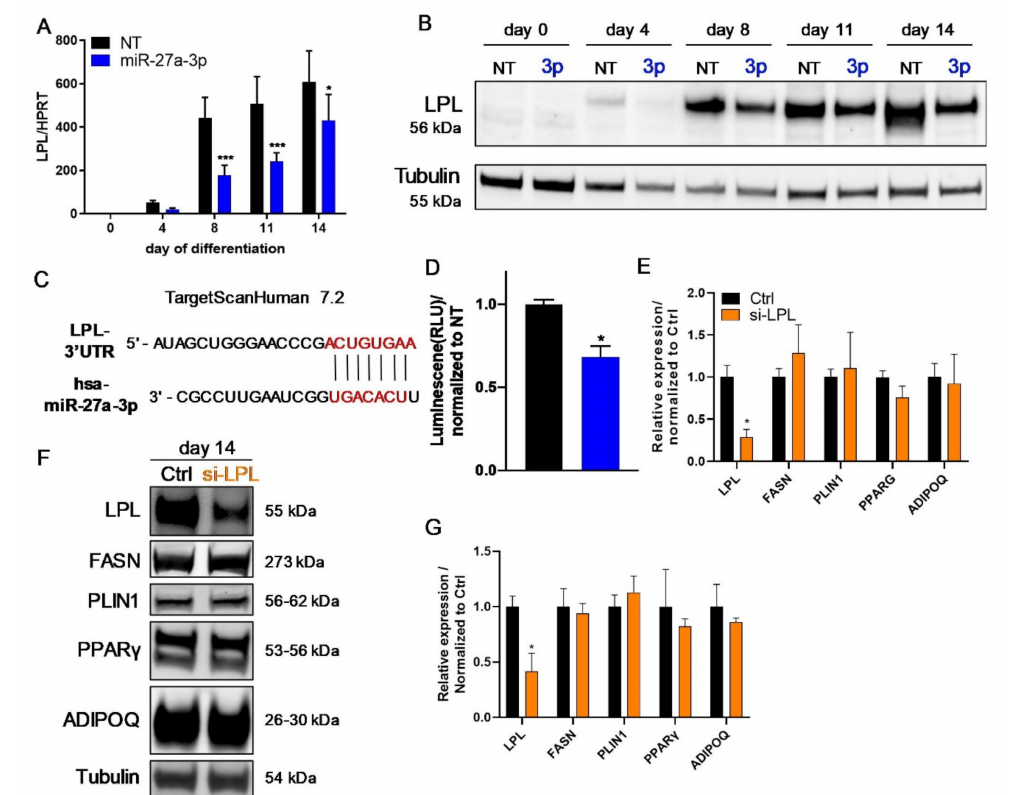
Figure 6. The miR-27a-3p target LPL does not alter adipogenesis. To assess if miR-27a-3p regulated its predicted target, lipoprotein lipase (LPL), SGBS preadipocytes were transfected 48 h prior to adipogenic induction with miRNA mimics or non-target control (NT, 20 nM), and additionally, a dual-luciferase reporter assay was performed in HEK293 cells. ( A ) mRNA level of LPL as quantified by qPCR normalized to HPRT at indicated time points of adipogenic differentiation. ( B ) One representative Western blot from three independently performed experiments for LPL using tubulin as loading control. ( C ) Illustration of the predicted binding site for miR-27a-3p in the 3 (cid:48) UTR in the human LPL mRNA. ( D ) Results of the dual-luciferase reporter assay performed in HEK293 cells. Luminescence from firefly/Renilla luciferase activity was determined as indicated. ( E – G ) SGBS preadipocytes were transfected 48 h prior to adipogenic induction with either control non-target (Ctrl) or an siRNA pool targeting human LPL (si-LPL, 20 nM). RNA and protein samples were collected on day 14 of the differentiation process. ( E ) mRNA expression of LPL and adipogenic markers as quantified by qPCR normalized to HPRT after LPL knockdown. ( F ) One representative Western blot out of three independent experiments after LPL knockdown in SGBS cells. ( G ) Densitometric analysis of all Western blots on day 14 of adipogenesis normalized to tubulin. Statistics: results are displayed as means and SEMs of 5 ( A ) and 3 ( B , D – G ) independent experiments. Two- way ANOVA with Bonferroni correction ( A ); t -tests ( D , E , G ) with respect to NT/Ctrl for the same time point; * p < 0.05; *** p < 0.001. HPRT: hypoxanthine-guanine phosphoribosyltransferase; FASN: fatty-acid synthase; PLIN1: perilipin; PPAR γ : peroxisome proliferator-activated receptor γ ; ADIPOQ: adiponectin; 3p: